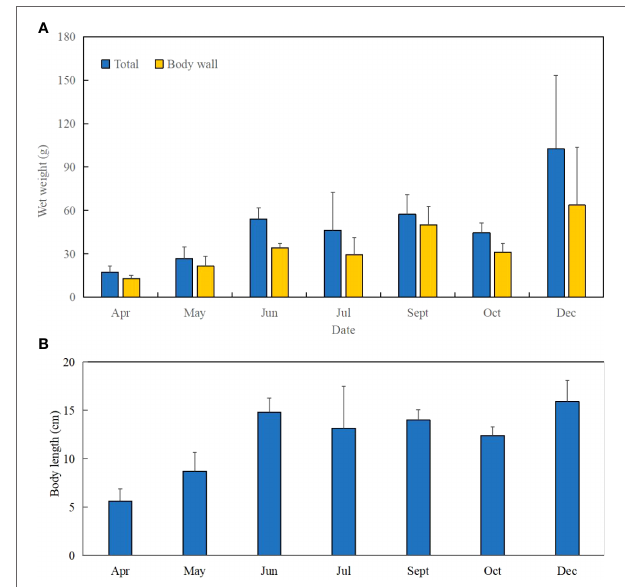
FIGURE 4 | Increase of wet weight and body length of S. monotuberculatus from April to December 2019. (A) Change of wet weight of S. monotuberculatus from April to December 2019. (B) Change of body length of S. monotuberculatus from April to December 2019.